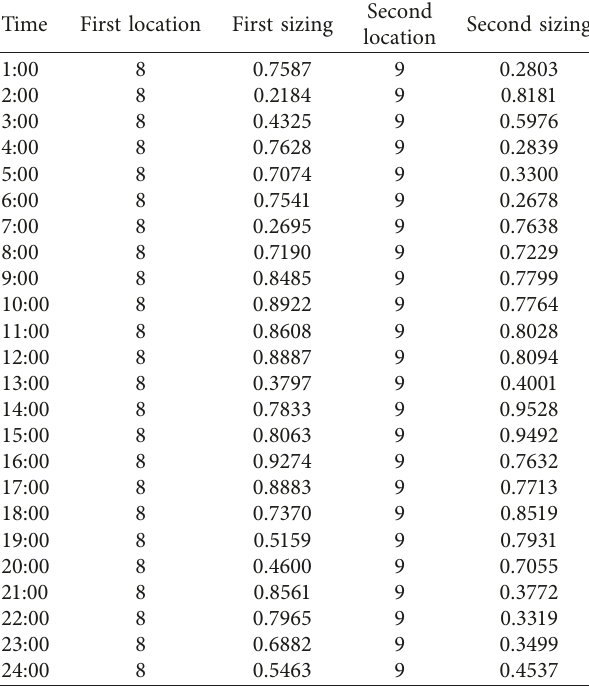
Table 9: The first-layer decision variables.